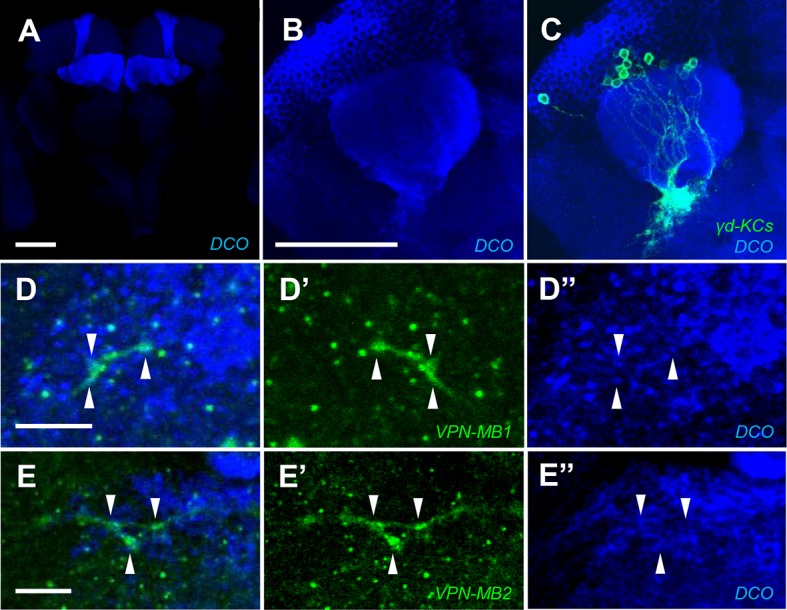
VPN axons overlap with KC processes in the vAC labeled with DC0.(A–C) The DC0 antibody highlights KCs including the γd neurons labeled by MB419B-GAL4. (D and E) The γd dendrites overlap with the processes of VPN-MB1 (MB425B-GAL4) (D) and VPN-MB2 (MB334C-GAL4) (E) Scale bars represent 50 µm (A and B) and 5 µm (D and E).